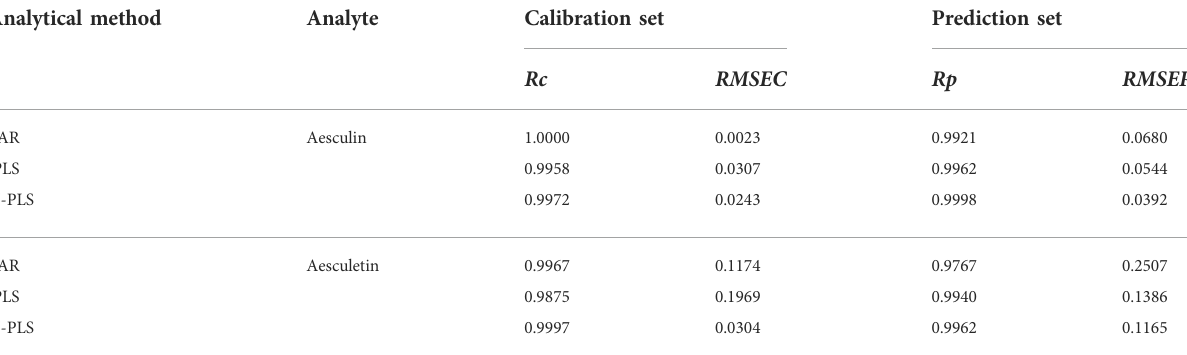
TABLE 1 Statistical parameters related to the calibration and prediction models of aesculin and aesceletin established by different